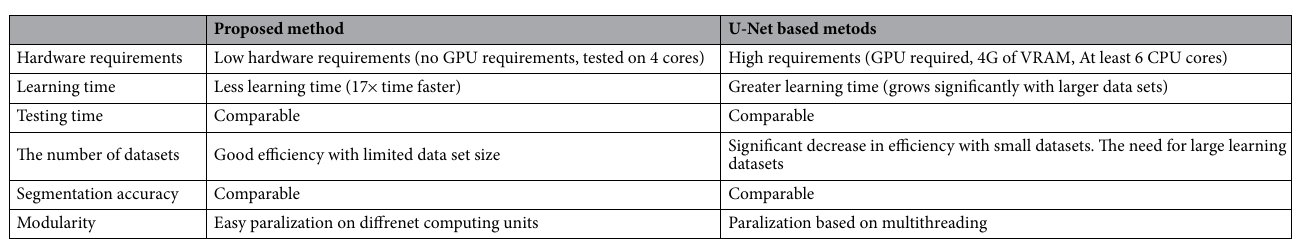
Table 5. A table comparing advantages of our solution in comparison to U-Net based methods in four categories: hardware requirements, training and testing time, size of data sets, and segmentation